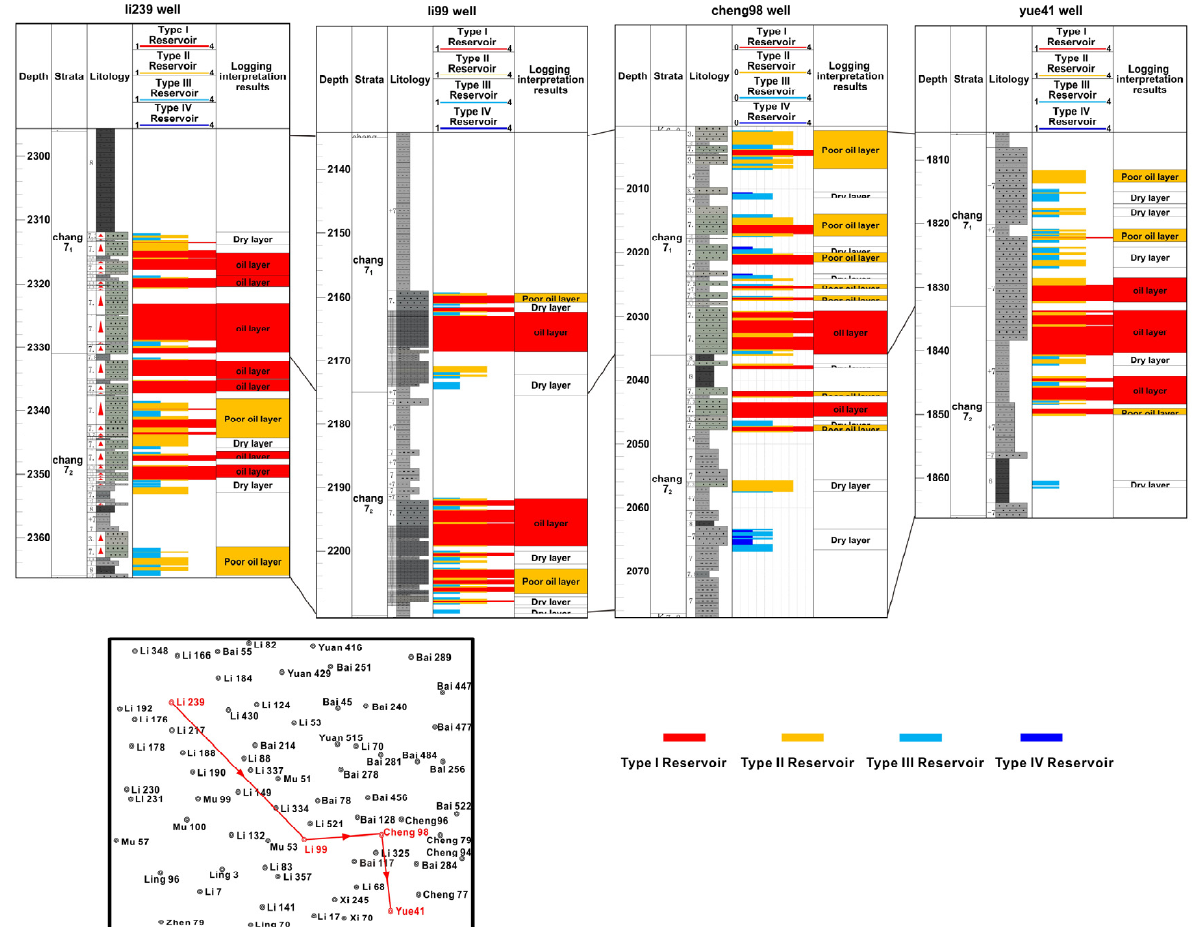
Figure 15. Correlation of different shale oil reservoirs and oil layers from Well Li 239 to Well Yue 41 wells in the Chang 7 1-2 sub-member.